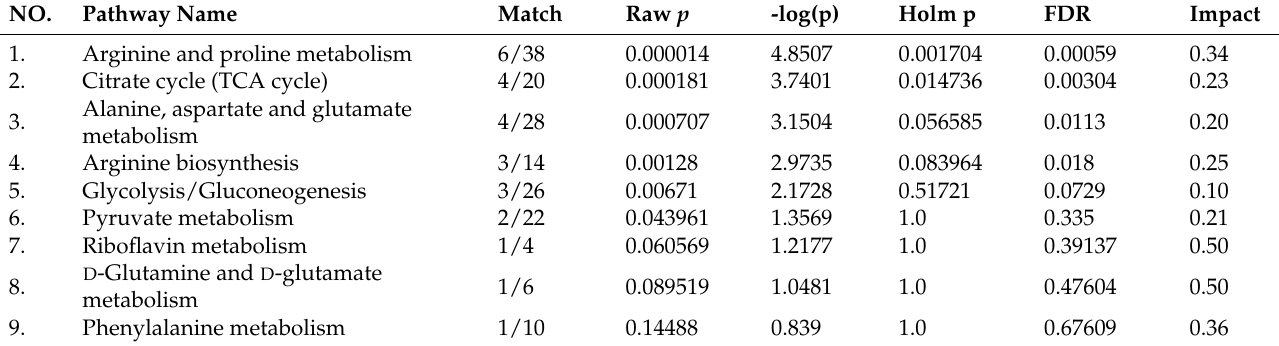
Table 3. Results of the ingenuity pathway analysis of uninfected RBCs treated with CQ by using MetaboAnalyst (MetPA) showing the impact values.